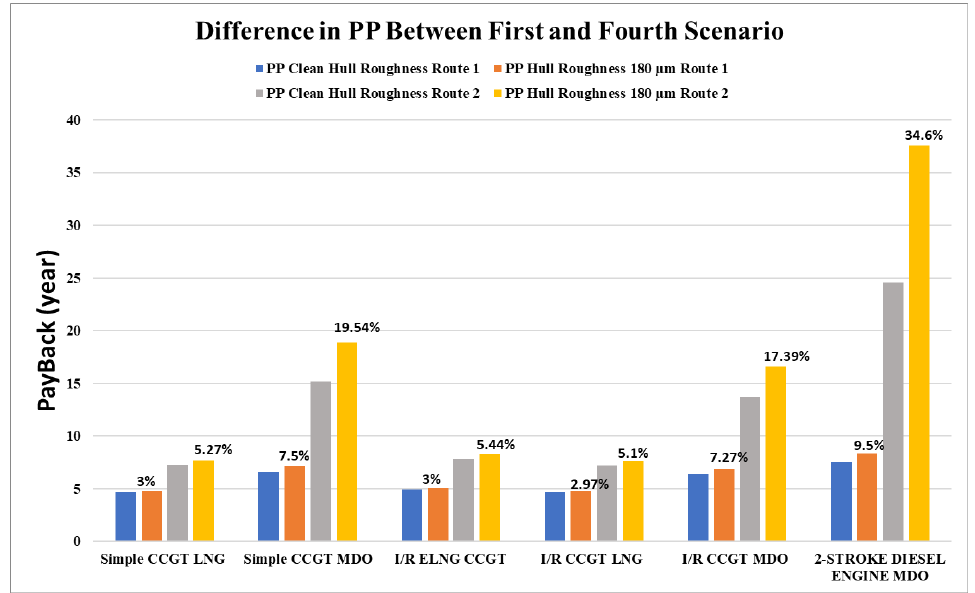
Figure 11. Difference in PP between the first and fourth scenarios for Routes 1 and 2.